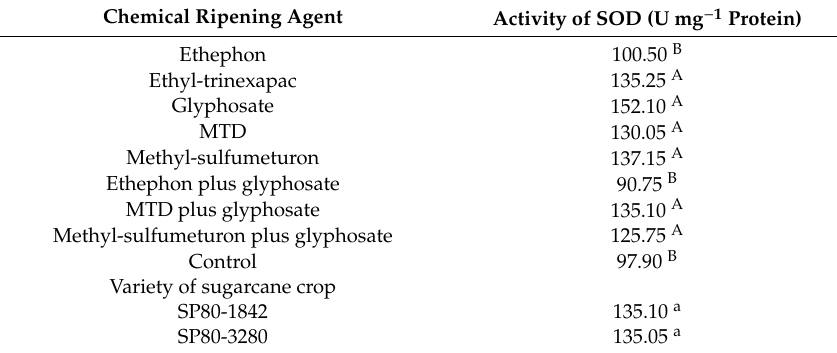
E ff ects of chemical ripening agents and varieties of sugarcane on the activity of superoxide dismutase.